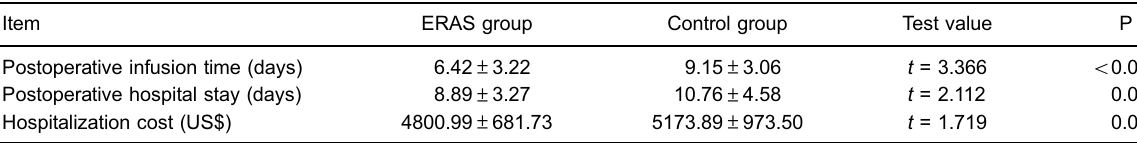
Table 4. Comparison of economic indicators between two groups of